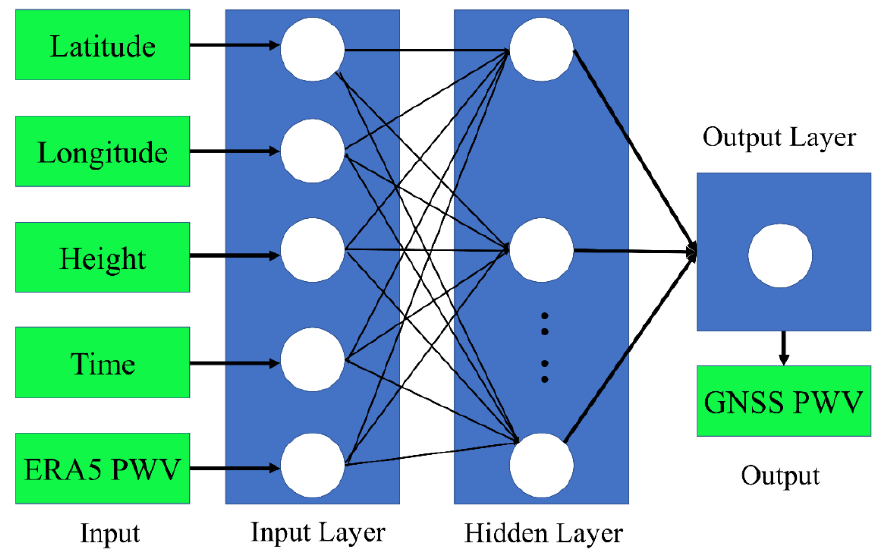
Figure 2. Structure of the BPNN model.